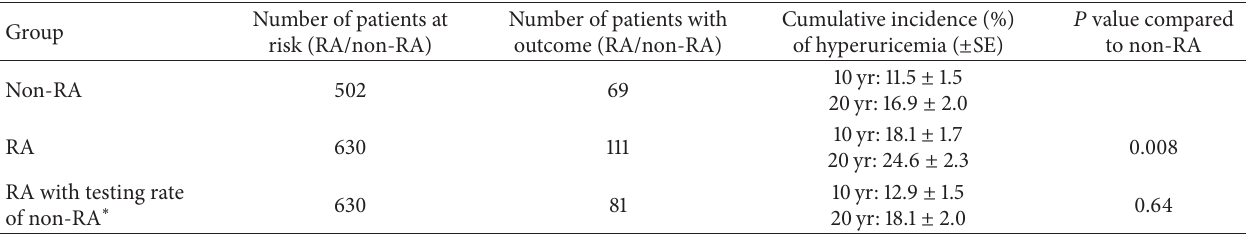
Table 2: Cumulative incidence of hyperuricemia in patients with rheumatoid arthritis (RA) compared to subjects without RA (non-RA).